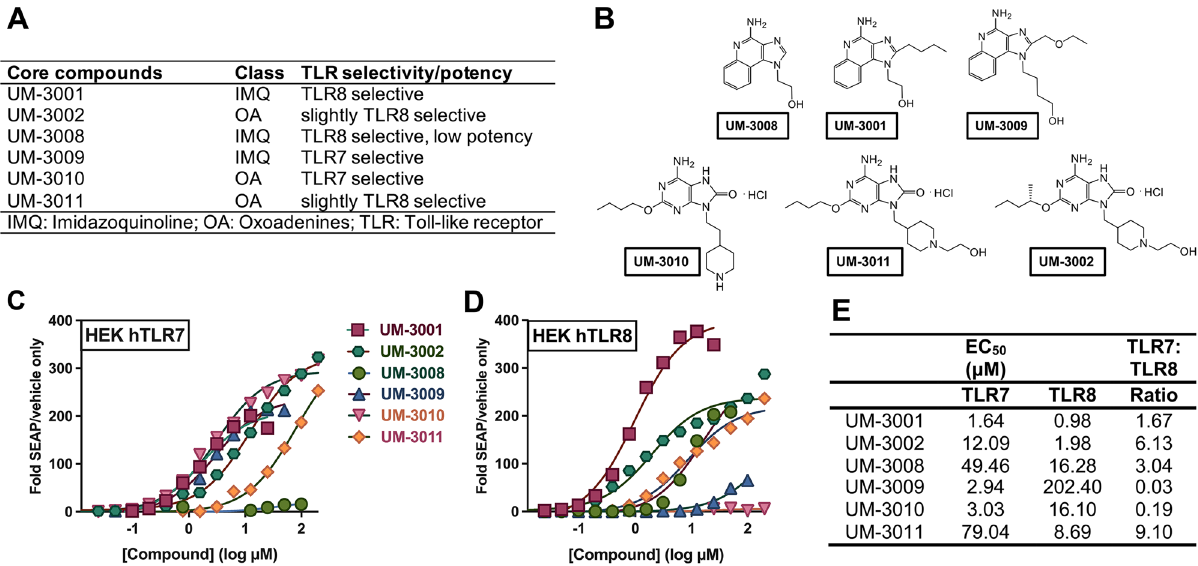
Figure 1. Overview of the core-aqueous imidazoquinoline and oxoadenine scaffolds. ( A ) Naming convention, chemical class and TLR selectively of each core scaffolds 43,60,75,76 ; ( B ) core imidazoquinolines and core oxoadenines investigated in this study. ( C – D ) Six TLR agonists were compared. HEK-293 cells transfected with ( C ) human TLR7 or ( D ) human TLR8 and an NF-kB-driven reporter SEAP gene were stimulated for 18–24 h with TLR agonists. The y-axis shows the level of SEAP activity as a fold change over unstimulated cells. The x-axis shows the concentration of each compound in μM (log 10 scale). Each data point represents the mean of triplicate culture wells, and representative of three separate experiments. ( E ) Amongst the IMQ and OA compounds evaluated in a HEK293 assay, UM-3001 was the most potent with lowest half maximal effective concentration (EC 50 ) for both TLR7 and TLR8, with a preference for